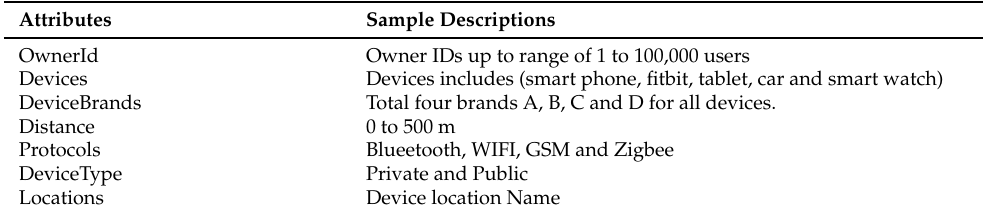
Table 5. Device profile dataset.